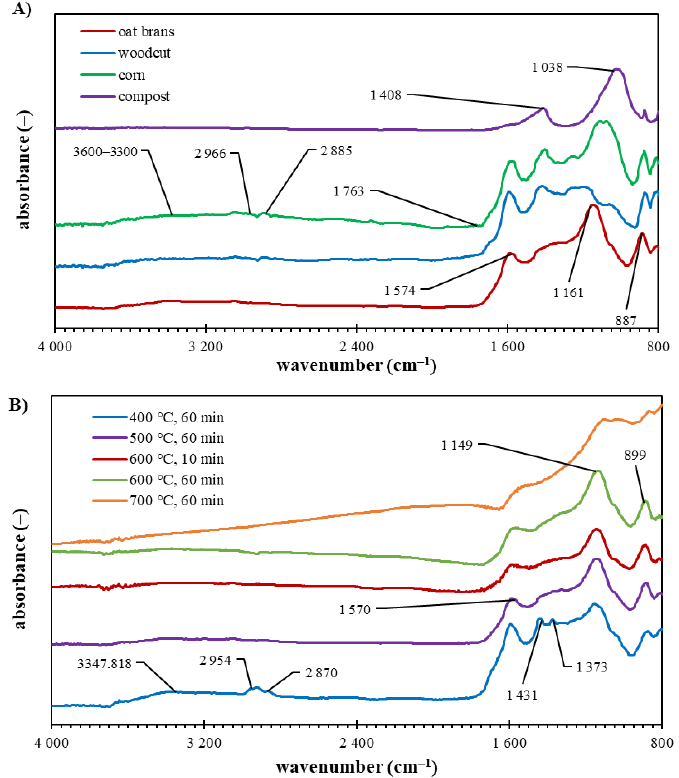
Figure 4. FTIR spectra of biochar samples: ( A ) originated from different feedstocks prepared at 500 °C (residence time 60 min); ( B ) at different pyrolysis temperatures and residence time originating from oat brans.